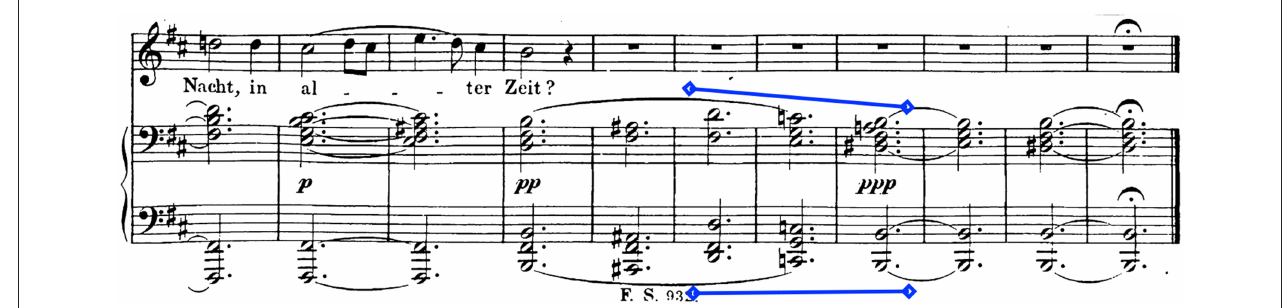
FIGURE 1 | Extract of Schubert’s lied “Der Doppelgänger” (Henrich Heine). Chords in a chord progression are not independent from each other but are linked according to musical rules or musical ideas. An example of such musical idea is shown in the work of Mishkin (1978), who analyzes that Schubert employs in some lieder of his last year harmonic parallelism between triads a half step apart when the poetic images evoke the supernatural. Mishkin provides an example with “Der Doppelgänger” where “the vocal line is supported by hollow sonorities in the piano accompaniment to suggest the dreamlike horror of beholding one’s own double weeping before the house of the departed beloved. The hallucinatory impression is intensified, in the concluding passage for piano alone (Indicated by the blue line in this figure), through an organum-like progression that moves in parallel motion through a triad on the lowered supertonic degree”